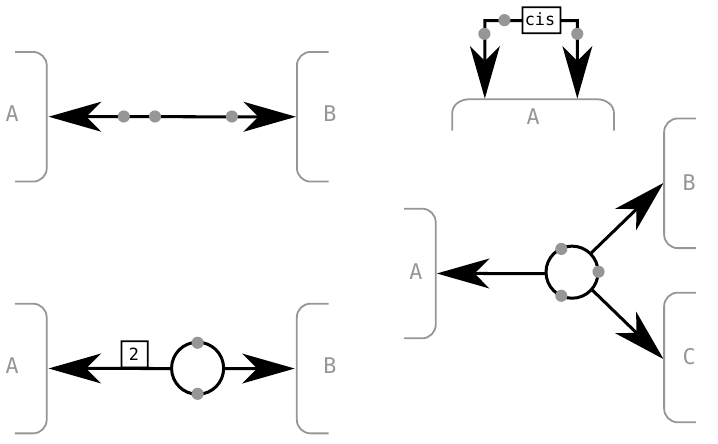
Figure 2.15: The Entity Relationship glyph for interaction . Top left, binary interaction between two entities. The circle can be ommitted, and the outcomes located anywhere on the interaction . Bottom left, because the cardinality of the entity A is 2, the interaction is not a binary one, but a n-ary one. The circle cannot be ommitted. Bottom right, n-ary interaction with three different entities. Top right, intra-molecular interaction.